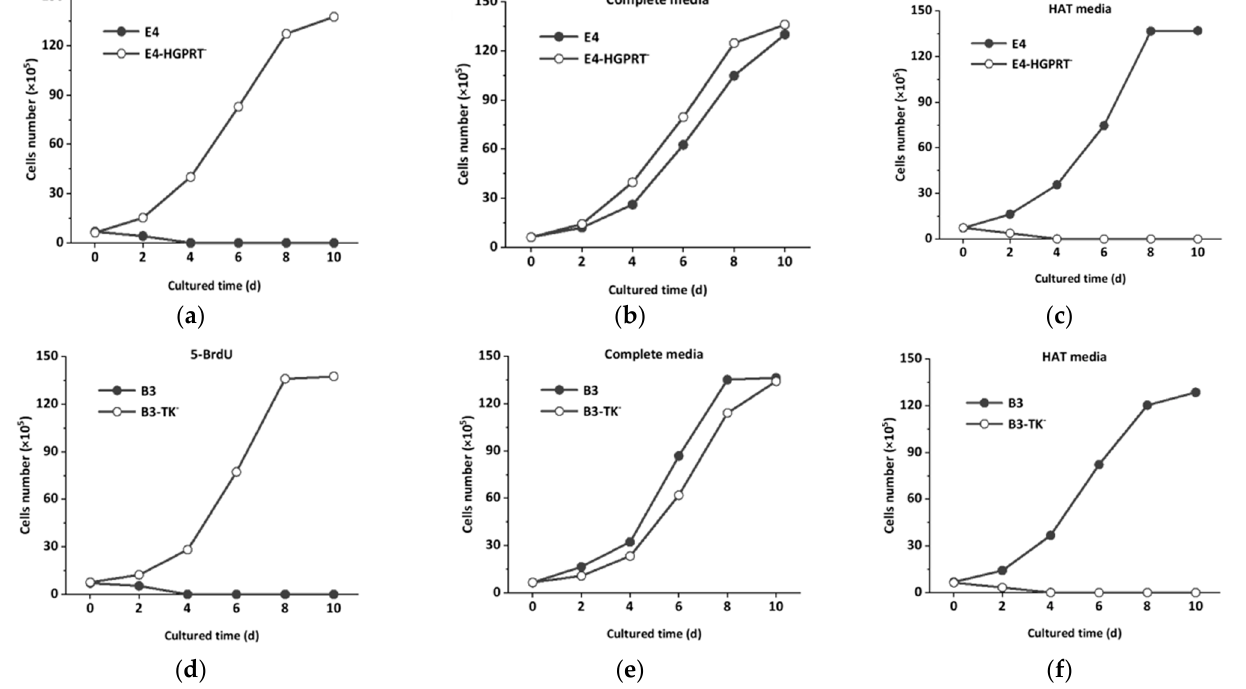
Figure 3. The growth curve of AFB 1 hybridoma cell lines E 4 and OTA hybridoma cell lines B 3: ( a ) cell line E 4 and E 4 -HGPRT - in 6-TG; ( b ) cell line E 4 and E 4 -HGPRT - in the complete media; ( c ) cell line E 4 and E 4 -HGPRT - in HAT media; ( d ) cell line B 3 and B 3 -TK - in 5-BrdU; ( e ) cell line B 3 and B 3 -TK - in the complete media; ( f ) cell line B 3 and B 3 -TK - in HAT media.